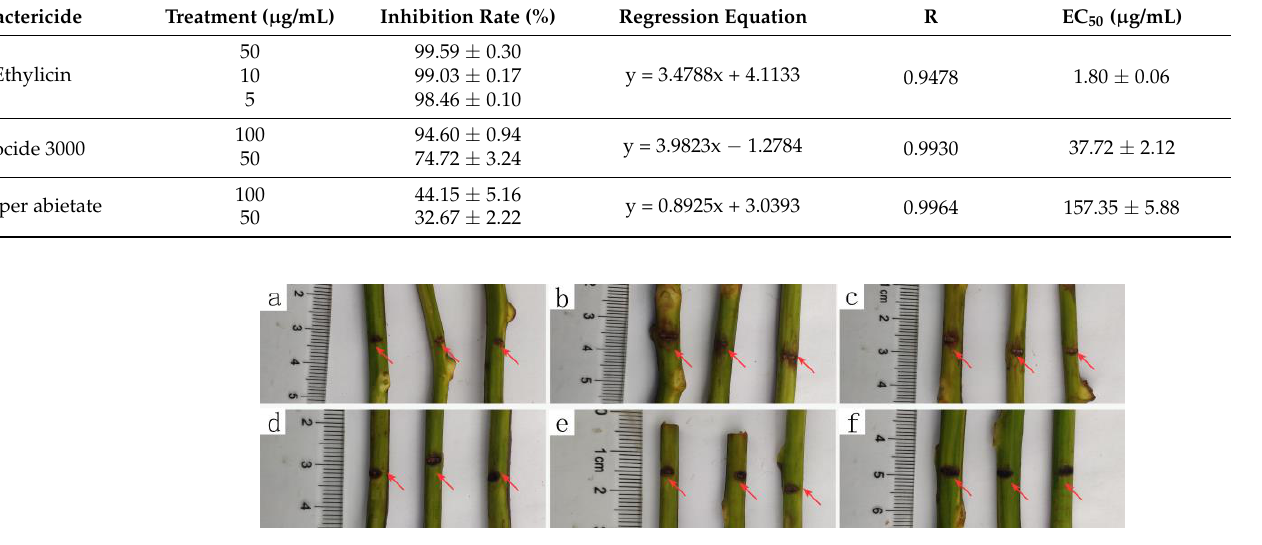
Figure 1. In vivo antibacterial activities of ethylicin against kiwifruit bacterial canker at 200 or 500 μg/mL on kiwifruit twigs: ( a ) blank control (no ethylicin and no bacterial inoculation); ( b ) Psa; ( c ) 200 μg/mL Kocide 3000; ( d ) 200 μg/mL ethylicin; ( e ) 500 μg/mL Kocide 3000; and ( f ) 500 μg/mL ethylicin. Table 2. Prevention effect of ethylicin on kiwifruit bacterial canker in vivo. Treatment